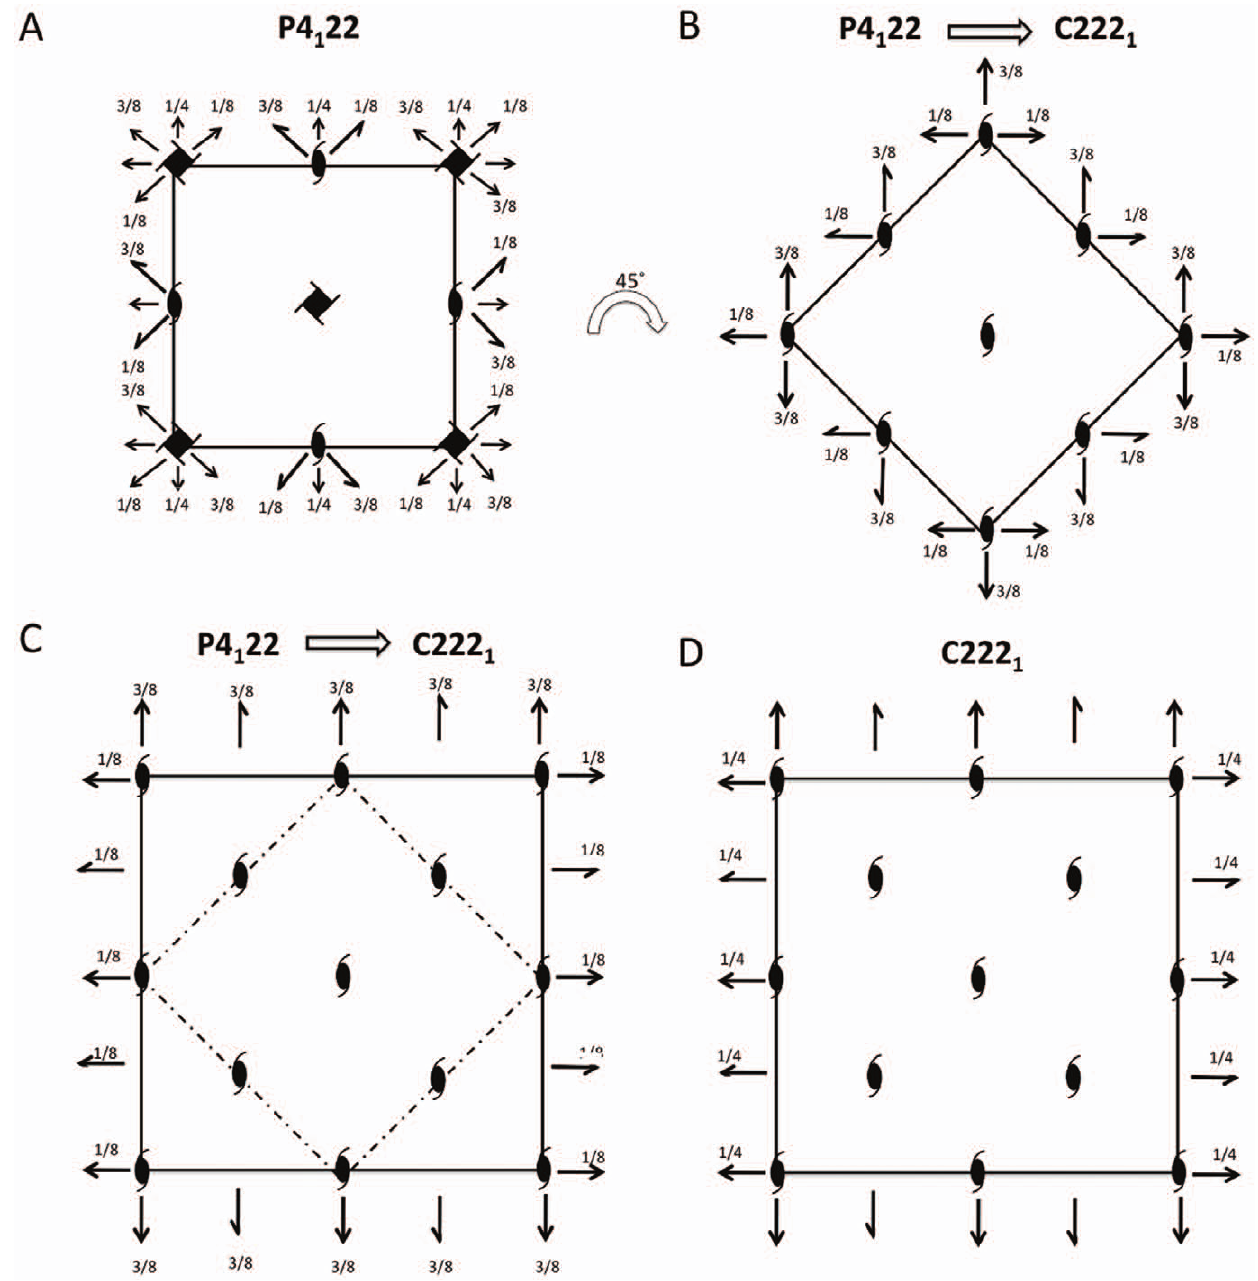
Figure 4. The transformation between space groups P4 1 22 and C222 1 . (A) The projection of symmetry elements in space group P4 1 22 along 4 1 axis; (B) Degeneration of P4 1 22: 4 1 axis are transformed into 2 1 axis, while the 2 fold axis, generated by 4 1 axis, disappear too. The cell is rotated clockwise by 45 u around 4 1 axis; (C) The cell parameter a 9 and b 9 in C222 1 space group take the diagonal direction along a + b and a 2 b of space group P4 1 22, respectively, and forms new unit cell; (D) In order to follow the international conversion of space group C222 1 , the origin is translated 3/ 8 cell length along c axis.